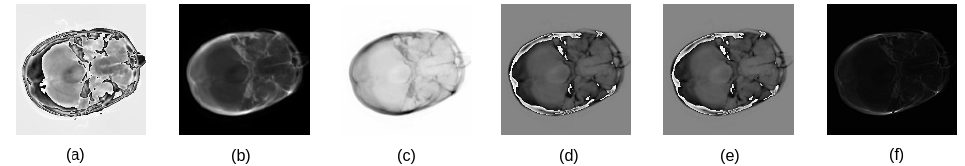
Figure 1. Example of image enhancement technique output for each step using CTP image. ( a ) Single channel, ( b ) gray-scale, ( c ) linear transformation, ( d ) log transformation, ( e ) smooth, and ( f ) edge